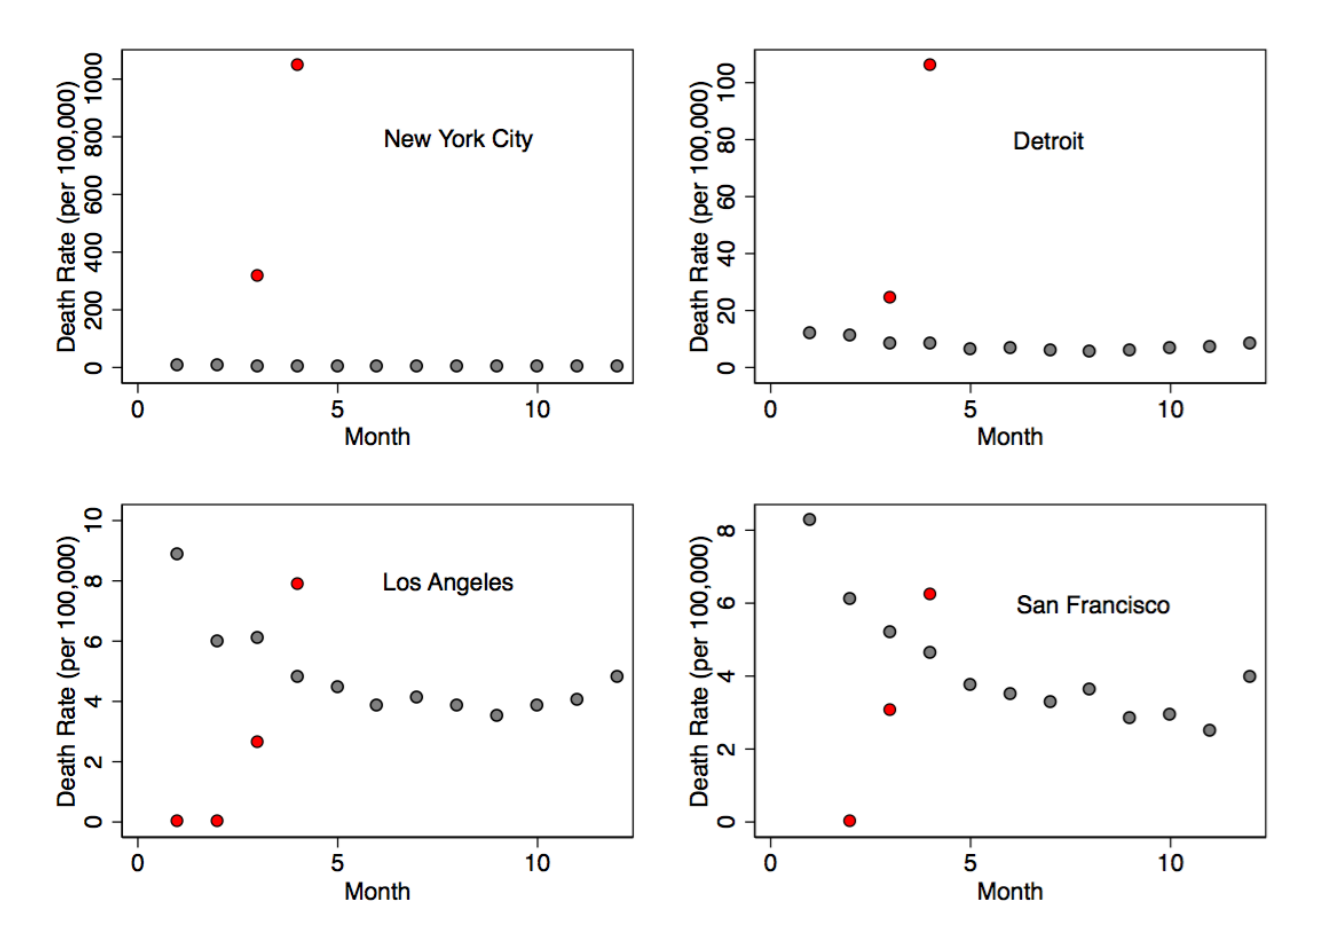
Figure A9. COVID-19 (2020) and total respiratory deaths (2018) in selected cities. Notes: Red indicates deaths due to COVID, black indicates all respiratory deaths. Source